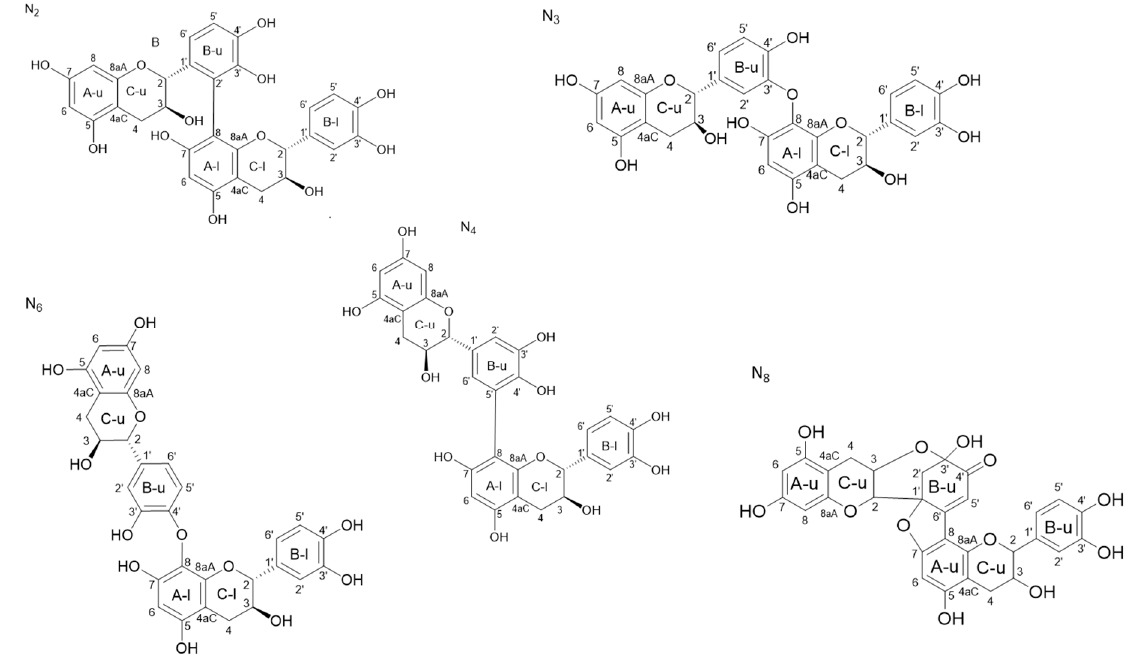
Figure 6. Structures of the six dimeric oxidation products formally identified by NMR analysis, N4 corresponding to a mixture of two isomers. Upper units rings are labelled with u and lower units rings are labelled with l.